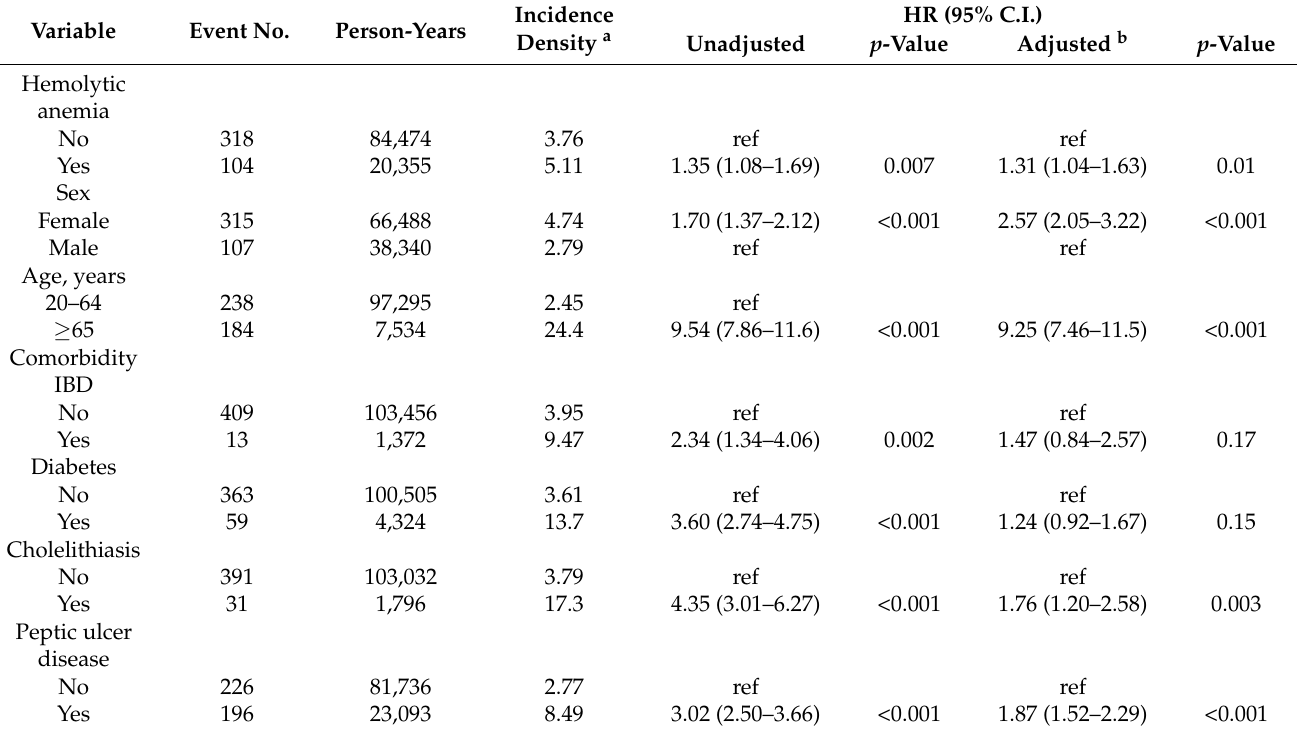
Table 2. Cox model-measured hazard ratios and 95% confidence interval of osteoporosis associated with hemolytic anemia and covariates.